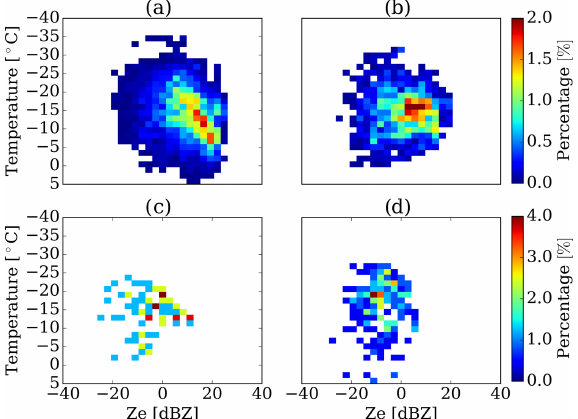
Figure D1. Joint distribution for temperature and Ze using radio soundings separated by surface precipitation (a, c) and virga (b, d) , for DDU (a, b) and PE (c, d) .